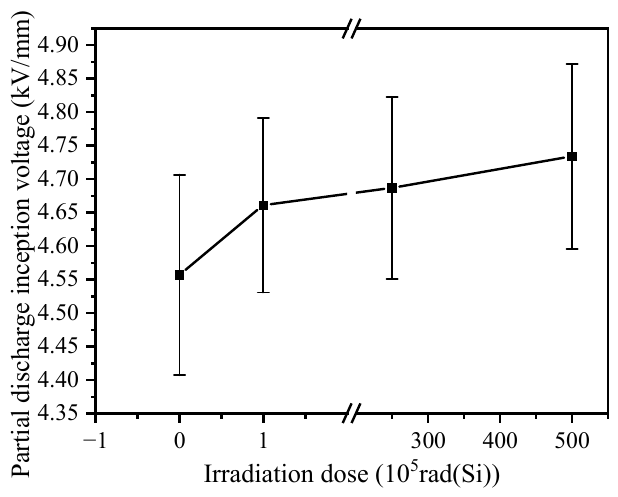
Figure 7. The variation of PD inception voltage with irradiation dose.